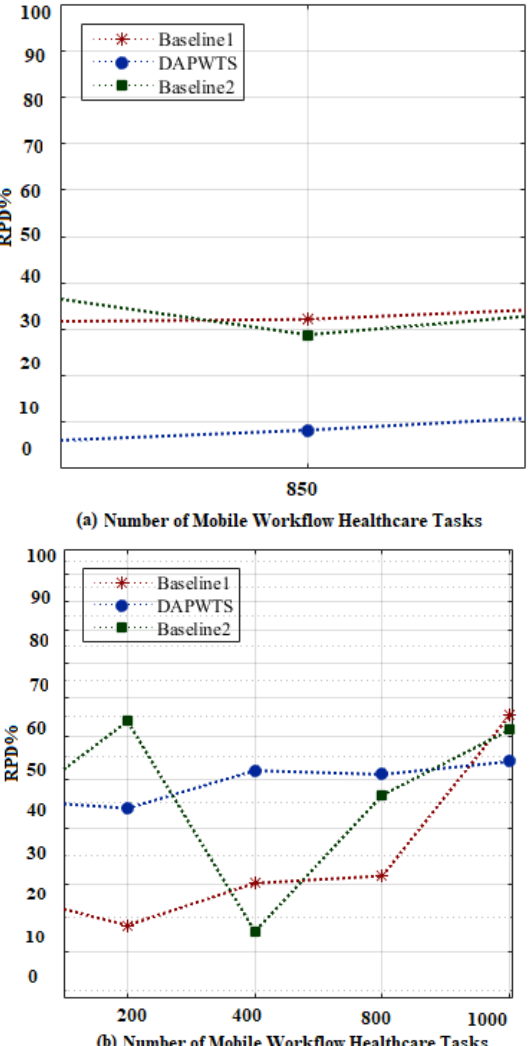
Figure 12. Failure energy-performance of tasks of applications G1.